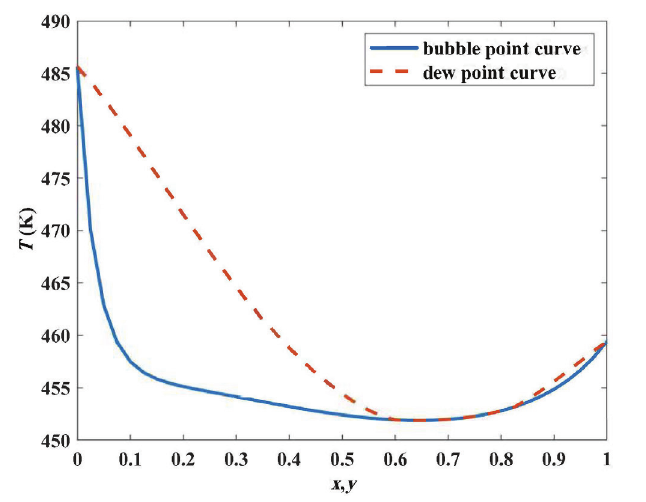
Fig. 2 – T - xy diagram for the binary system of IPA (1) and Water (2) at pressure of 20 bar